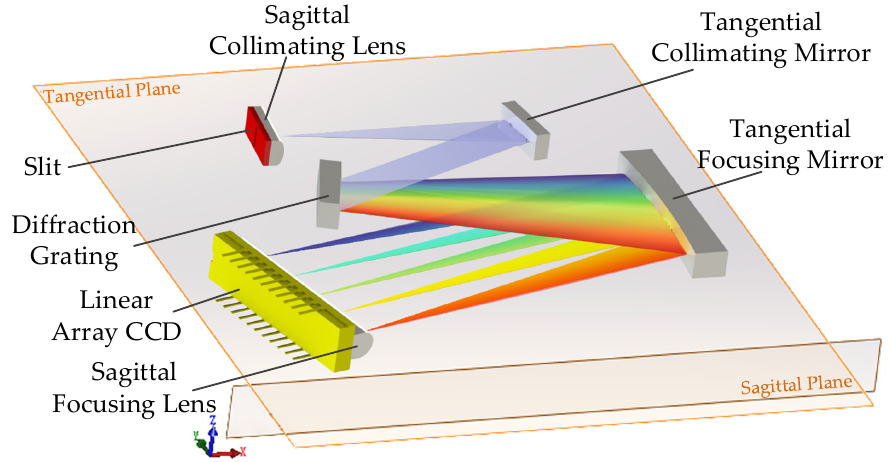
Figure 1. Schematic diagram of an ultra-thin Czerny–Turner (UTCT) spectrometer, consisting of cylindrical lenses and mirrors, where XY plane is the tangential plane of UTCT while XZ plane is the sagittal plane of UTCT.